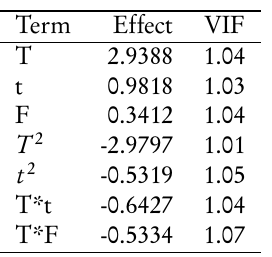
Effects of the terms of the final model in coded units and VIF. T = Temperature, t = Time, F = Force per cm 2